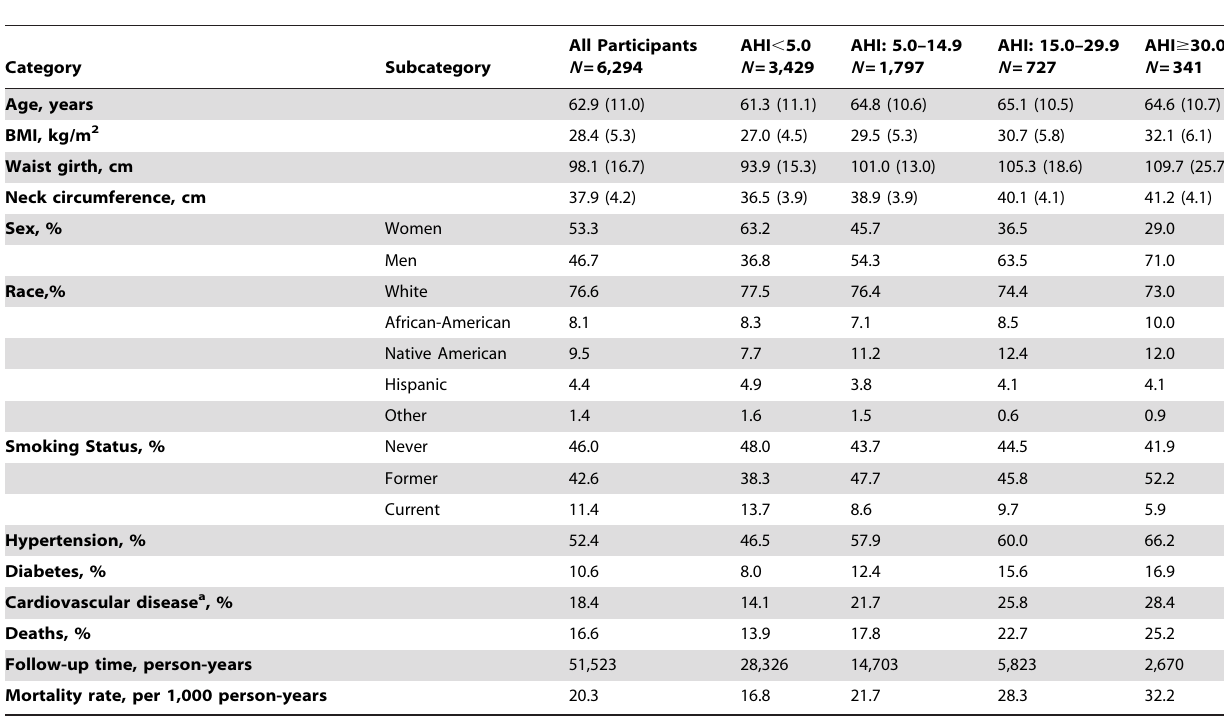
Table 1. Baseline characteristics, mortality, and follow-up times of the Sleep Heart Health Study cohort by apnea-hypopnea index (AHI)